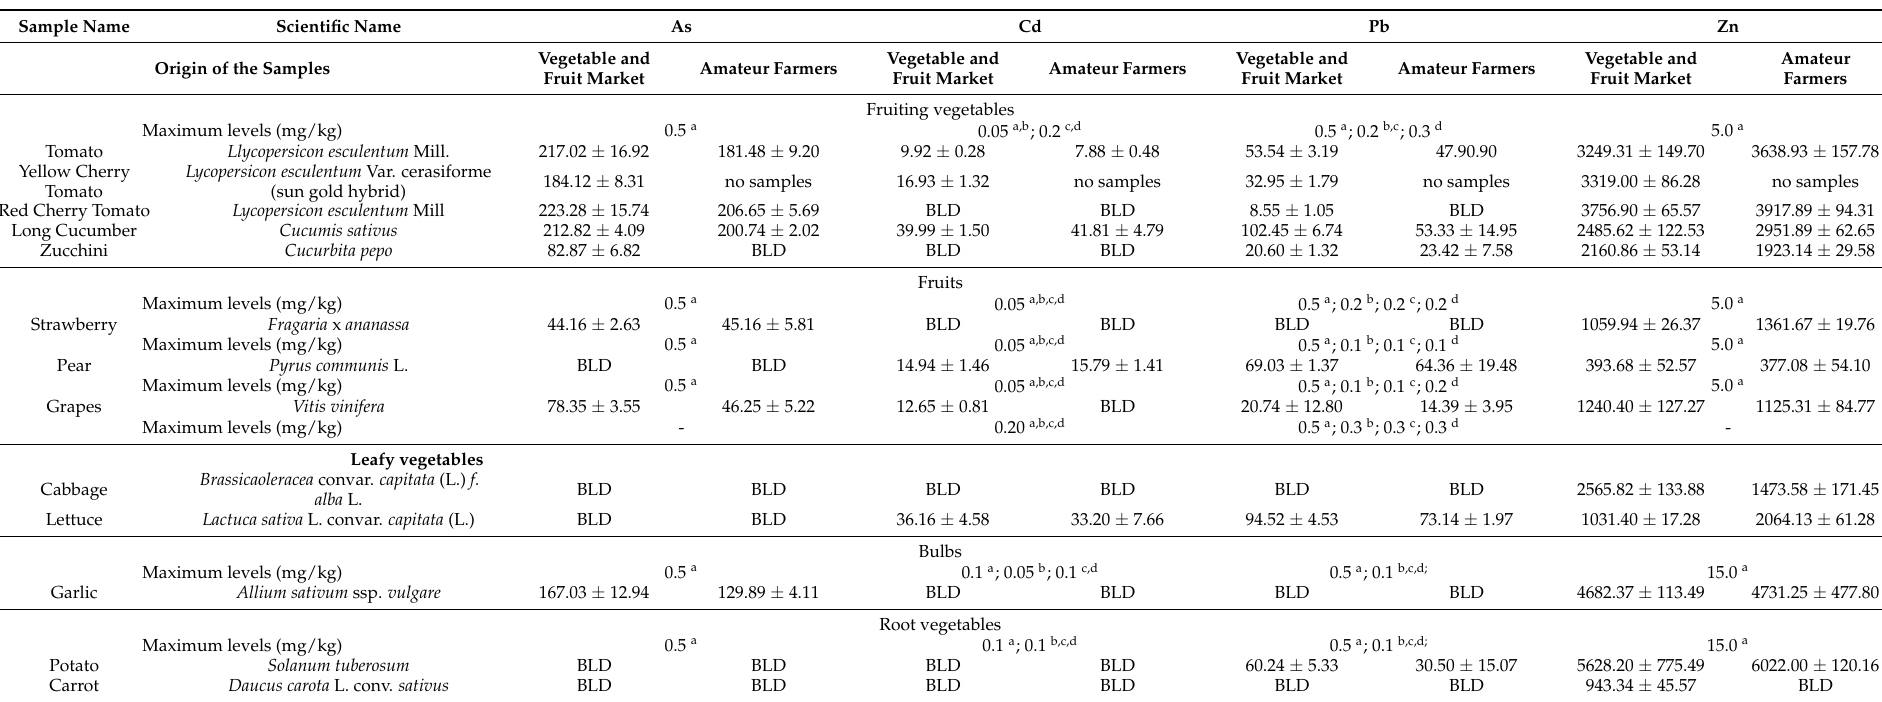
Table 3. Mean and standard deviation for heavy metal concentrations ( µ g/kg FW) in fruiting vegetables, fruits, leafy vegetables, bulbs, and root vegetables (n = 80) (samples washed with vinegar—10% acetic